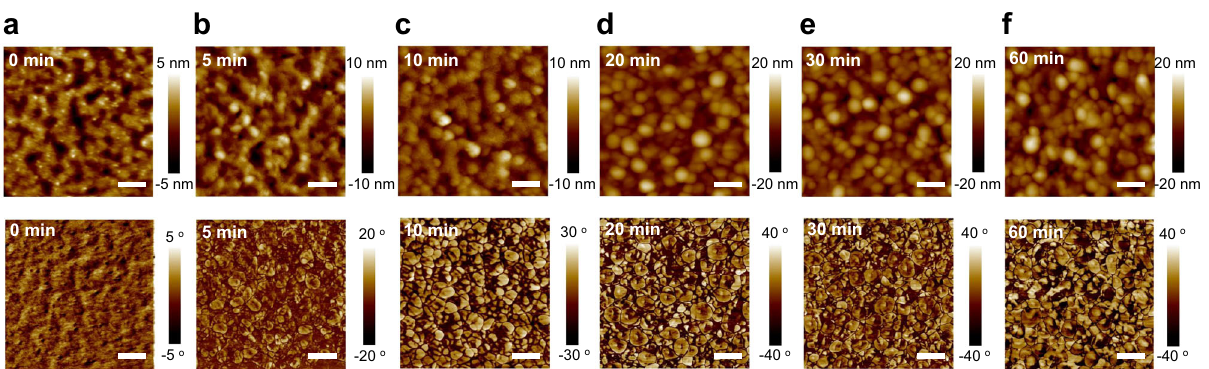
Fig. 3 Atomic force microscopy images of the MQW perovskite fi lms upon various annealing time (scale bar, 200 nm). The height and phase graphs show the fi lm roughness increasing and grain growth along with annealing time, respectively. a 0 min. b 5 min. c 10 min. d 20 min. e 30 min. f 60 min